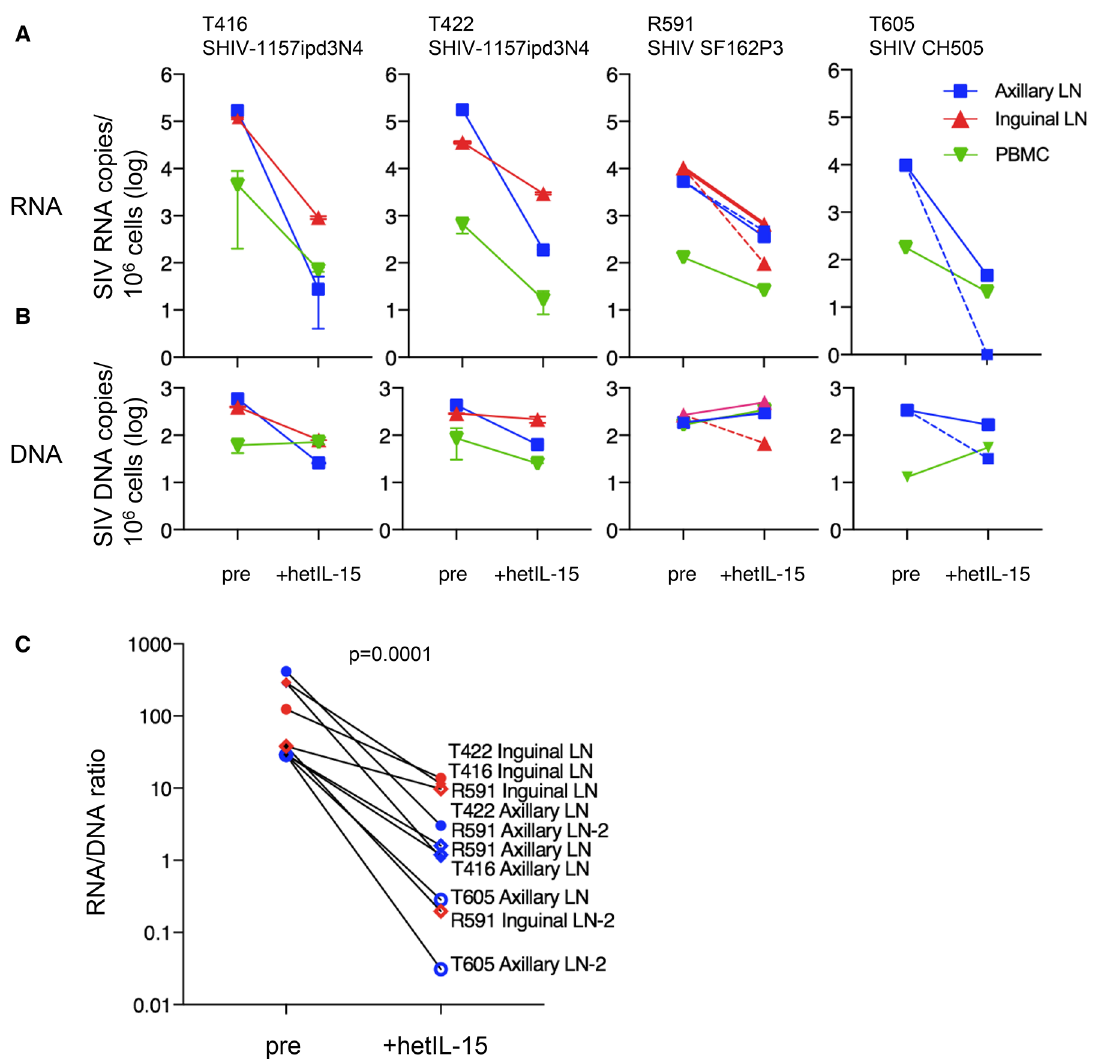
Fig 7. hetIL-15 treatment reduces the viral burden. (A) Quantitation of cell-associated viral RNA in axillary and inguinal LN and PBMC of 4 SHIV + macaques (T416, T422, R591, T605) upon hetIL-15 treatment. The viral RNA determinations in T416 and T422 are from duplicate measurements from purified flash-frozen LNMC and PBMC. The viral RNA determinations in R591 and T605 are from single measurements of flash-frozen LN before treatment and from two independent flash-frozen LN collected after hetIL-15. Dotted and solid lines denote the two independent LN samples. No inguinal LN was available for T605 post treatment. Axillary LN (blue square), inguinal LN (red triangle) and PBMC (green triangle) data are shown. (B) Quantitation of viral DNA copies from the samples of the macaques in panel A. (C) RNA/DNA ratio of the measurements shown in panels A and B. T416, filled diamond; R591, open diamond; T422, filled circle; T605, open circle. RNA/DNA ratio are for inguinal LN (red symbols) and axillary LN (blue symbols). p value for the difference before and after treatment determined by Mann-Whitney